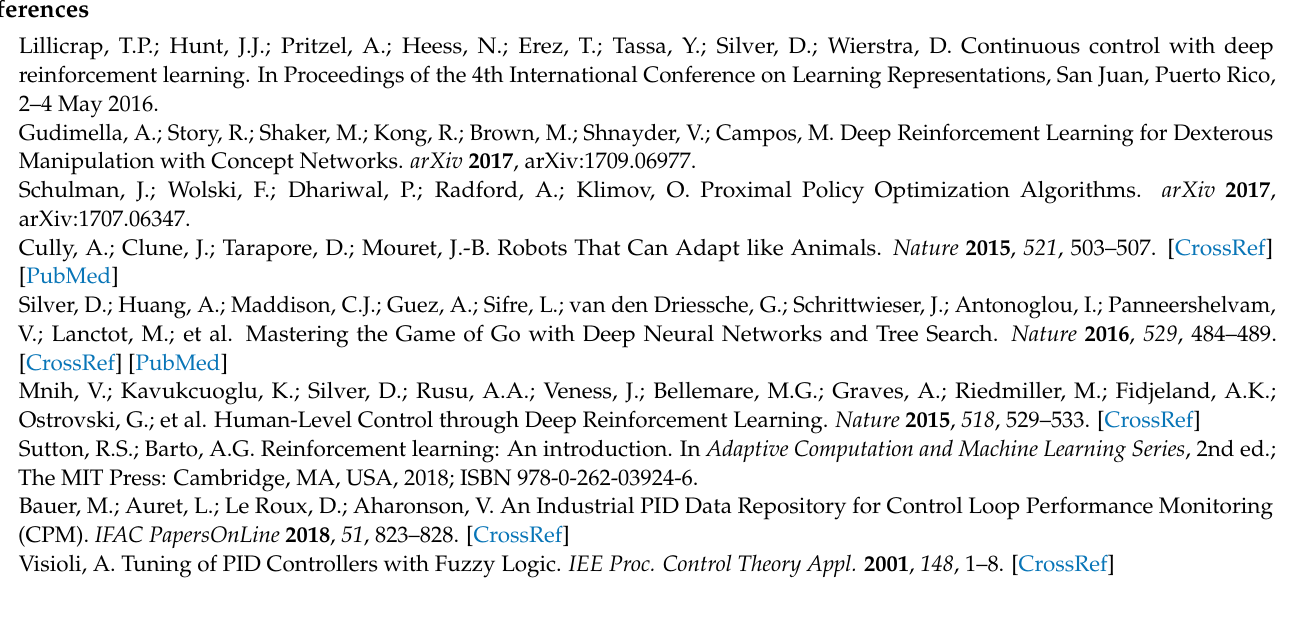
Note that the number of neurons in each hidden layer of the policy function and value function is treated as a separate degree of freedom in the hyper-parameter search. Therefore, each network can have between one and four layers, with each layer having a different number of neurons. Finally, the policy and value networks can share their hidden layers. The three activation functions are the hyperbolic tangent (tanh), rectified linear unit (relu), and leaky rectified linear unit